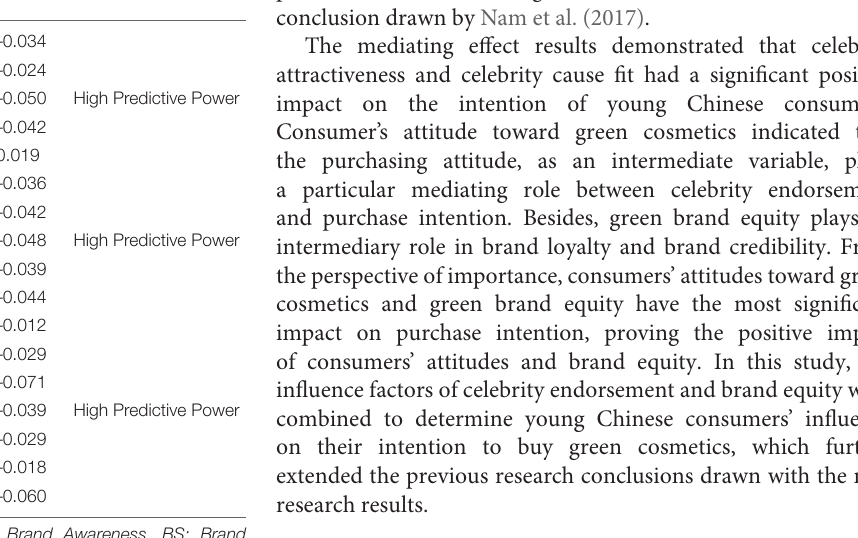
TABLE 8 | Predictive model assessment. Q 2